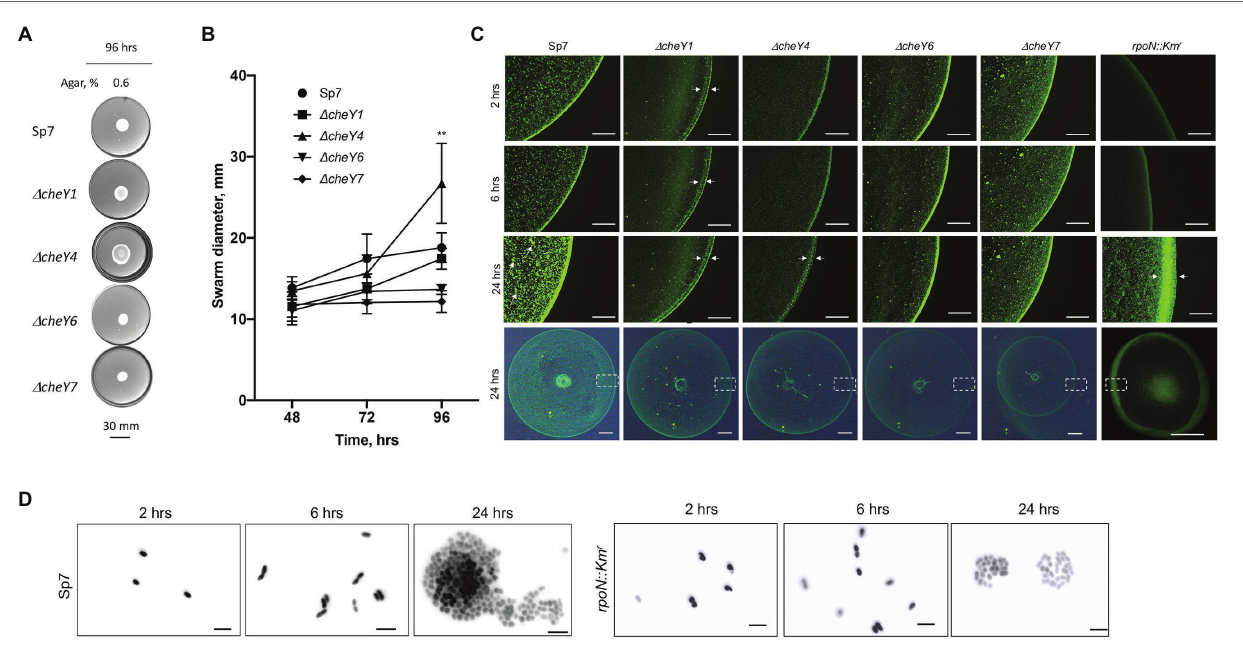
FIGURE 6 | Time course of swarming of A. brasilense and its chemotaxis response regulator mutants. The plates were solidified with 0.6% (w/vol) agar and incubated for 96 h post-inoculation at 28 ° C. (A) Representative images of swarming for the strains tested. (B) Quantitation of the ring diameters of Sp7 and mutant strains after 24–96 h of incubation on the swarming medium. Student t -test was used to determine significance between Sp7 and mutant strains (** p < 0.01). All experiments were done in triplicate. (C) The appearance of the border of the swarming colony of Sp7, ΔcheY1 , ΔcheY4 , ΔcheY6 , ΔcheY7 , and rpoN::Km strains harboring pHRGFP plasmid. The edge of the colony was photographed at 2, 6, and 24 h. The scheme at the bottom represents the area photographed. Scale bar: colony border images is 0.45 mm, whole colony is 1 mm. Exposure time for the colony border imaging is 9 s, for the whole colony 6.6 s. Arrows indicate inner and outer swarming rings in colonies of the ΔcheY1 and ΔcheY4 strains and cell clusters in the Sp7 swarming colony. (D) Visualization of the cell cluster formation by Sp7 (left panel) and rpoN::Km r cells in time. Scale bar = 5 μ